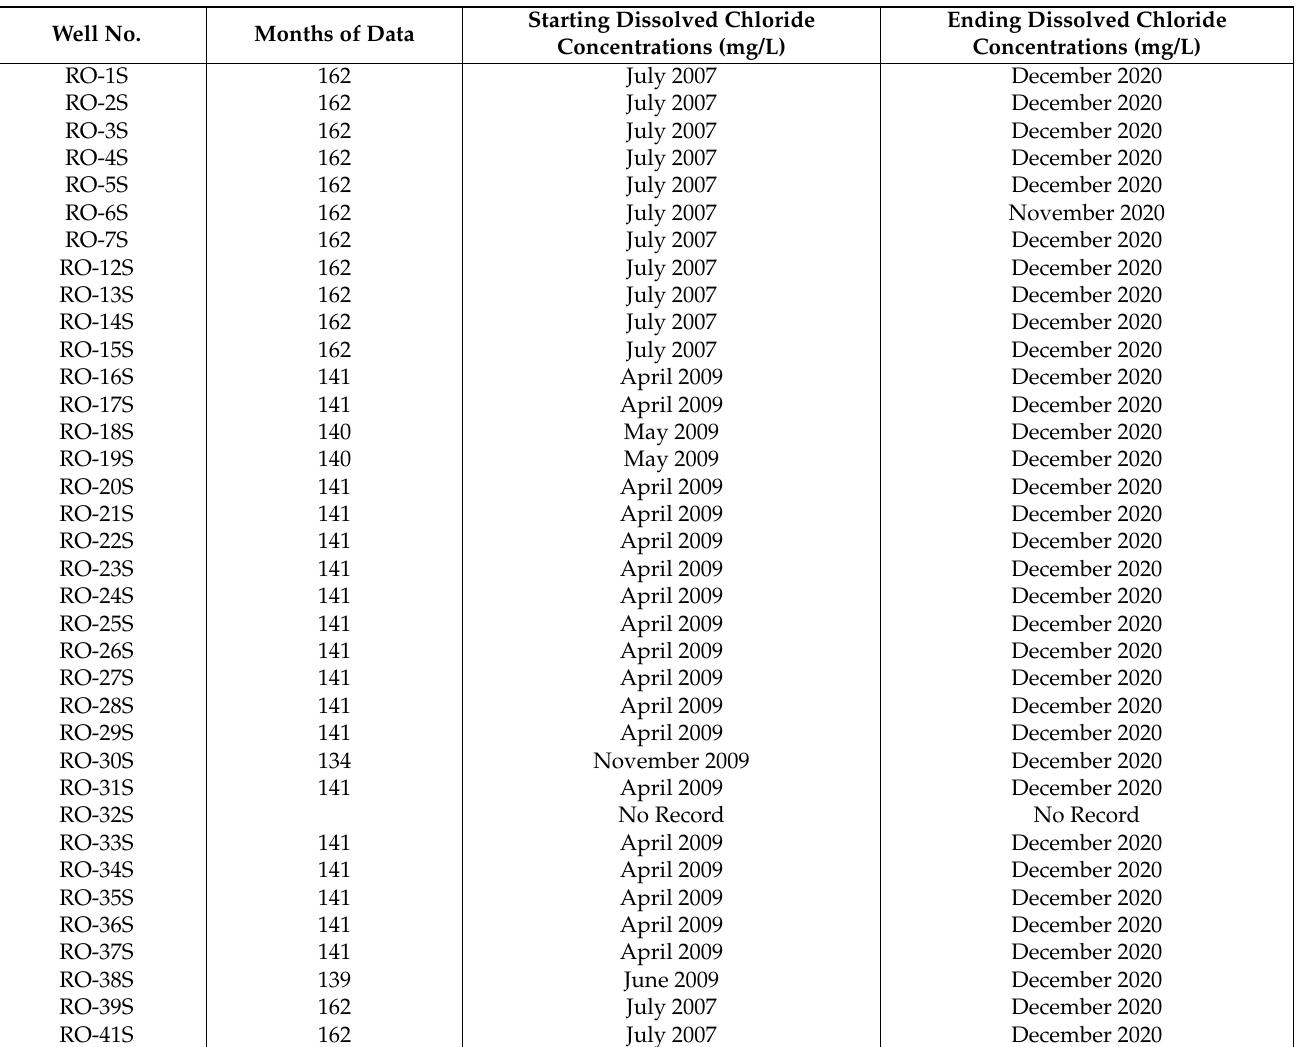
Table 2. Hawthorn Aquifer Zone 1 production wells period of recorded for starting and ending dissolved chloride concentrations measurements.